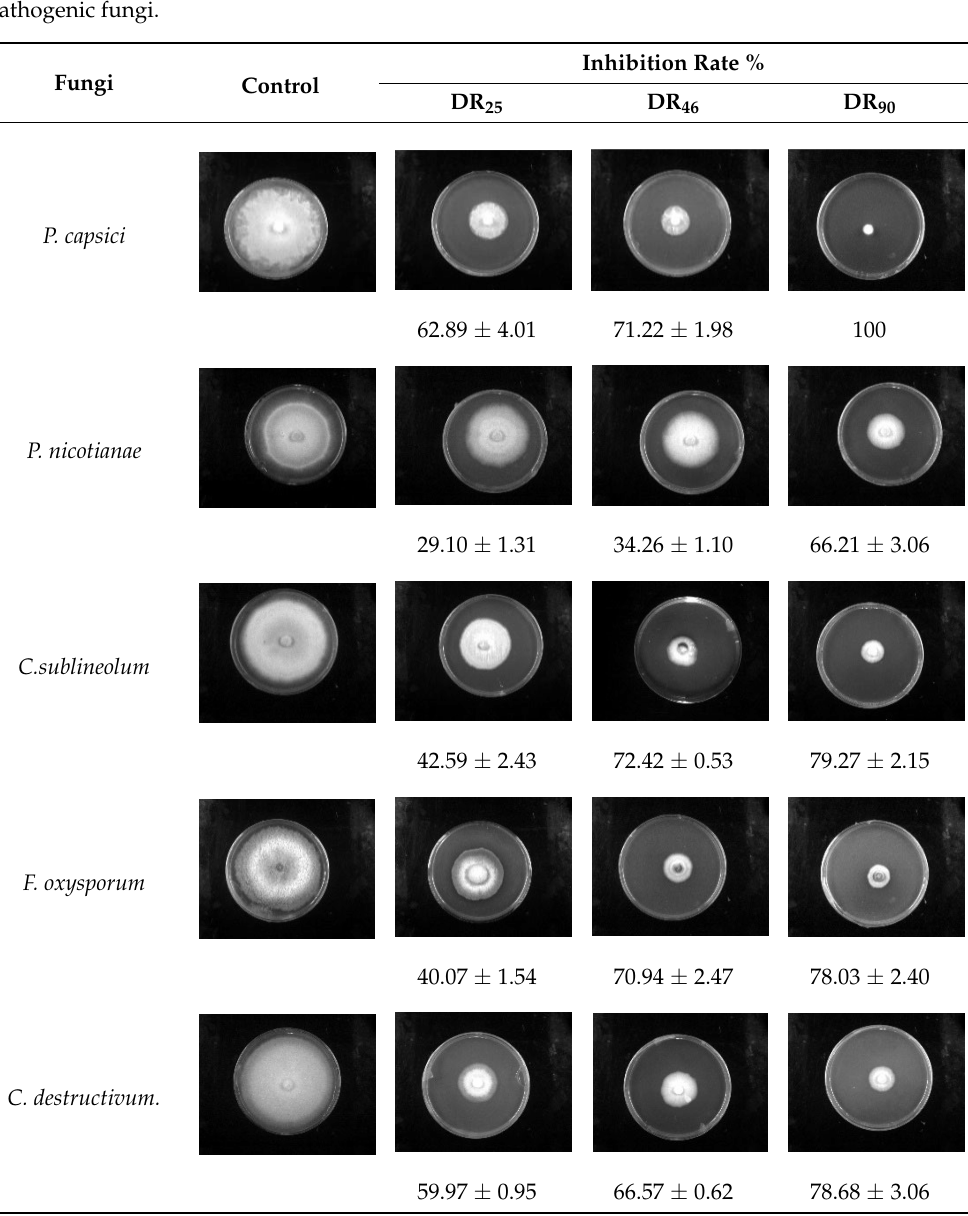
Table 4. The average mycelium inhibition rates (%) of rhamnolipids (200 mg/L) against five plant pathogenic